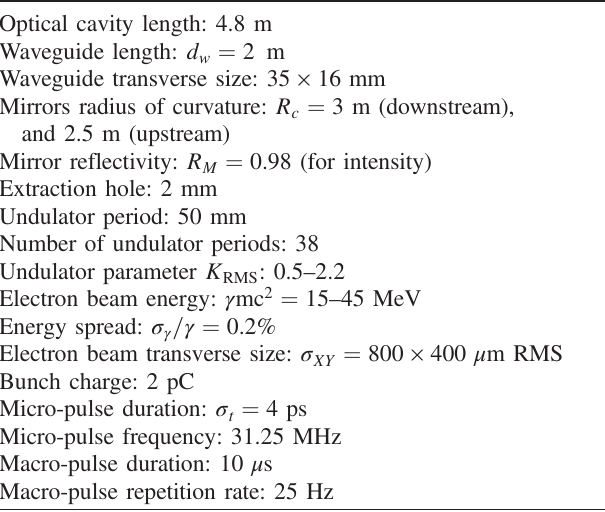
, cavity losses L and extraction rate L os , at λ ¼ 10 μ w